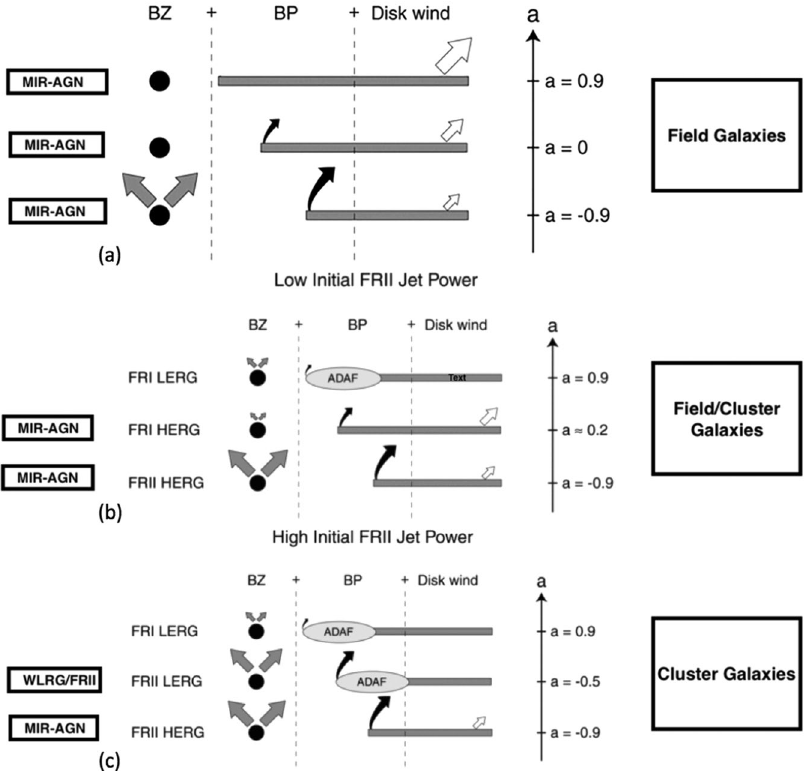
Figure 2. ( a )When the FRII quasar jet is not sufficient to alter the accretion mode, the system evolves into a prograde regime while remaining in a radiatively efficient state. As a result of this continued radiative efficiency of the disk, the disk wind suppresses the jet and a radio quiet quasar/AGN emerges. ( b ) Time evolution of an initially retrograde accreting black hole with intermediate jet power. The radiative efficiency of the initially radiatively efficient thin disk (lower two panels) evolves slowly into an advection-dominated disk. ( c ) Time evolution of an initially retrograde accreting black hole with powerful jets. The radiative efficiency of the initially radiatively efficient thin disk (lower panel) evolves quickly into an advection-dominated disk, which has a radiative efficiency that is at least two orders of magnitude smaller than the Eddington value. The jet is the result of a combination of the Blandford-Znajek process (BZ 18 ) and the Blandford-Payne process (BP 61 ) which explains the labels in the first and second columns. In ADAF states the radiative disk wind is absent. The arrows represent the radiatively-driven disk wind which increases with disk efficiency. The dimensionless spin parameter ‘ a ’ evolves from retrograde to zero and then up again in prograde regime due to continued accretion. Boxes on the right indicate environment. Note the association of WLRG/FRIIs with FRII LERGs. Left column describes the system in terms of its mid-infrared emitting timescale. The longer-lasting MIR emitter in ( a ) results from an accreting black hole whose torus structure is longer lasting. The evolution into an ADAF/LERG accretion state is associated with an absence of a torus and an enhancement in hard X-rays. This occurs slowly for ( b ) and quickly for ( c